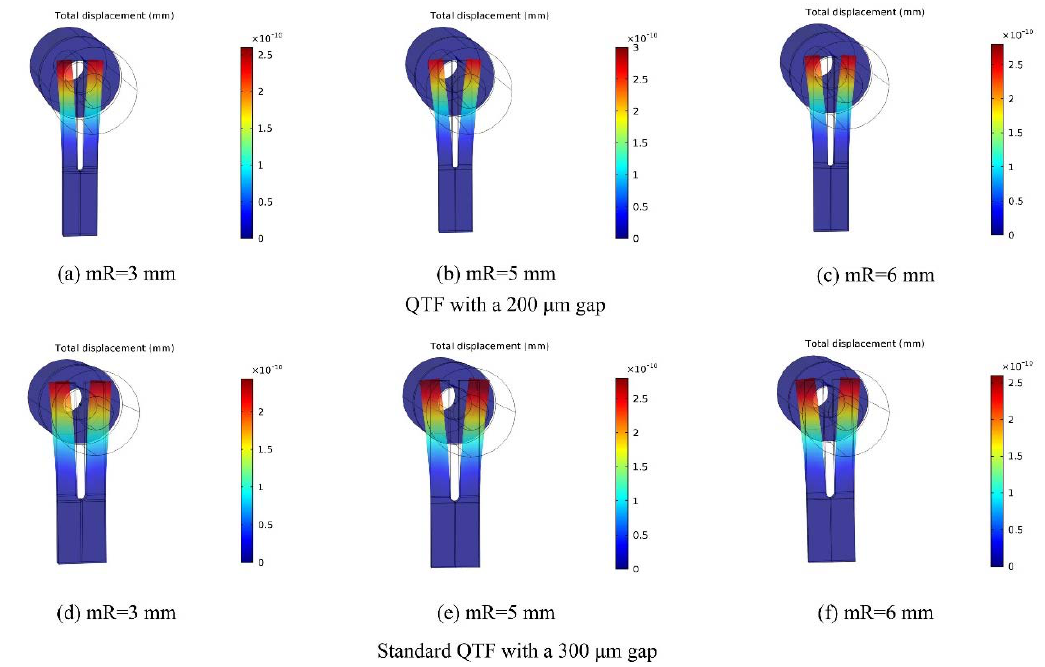
Figure 5. Calculated displacement with various micro-resonators (mRs) for two different QTFs: ( a – c ) for